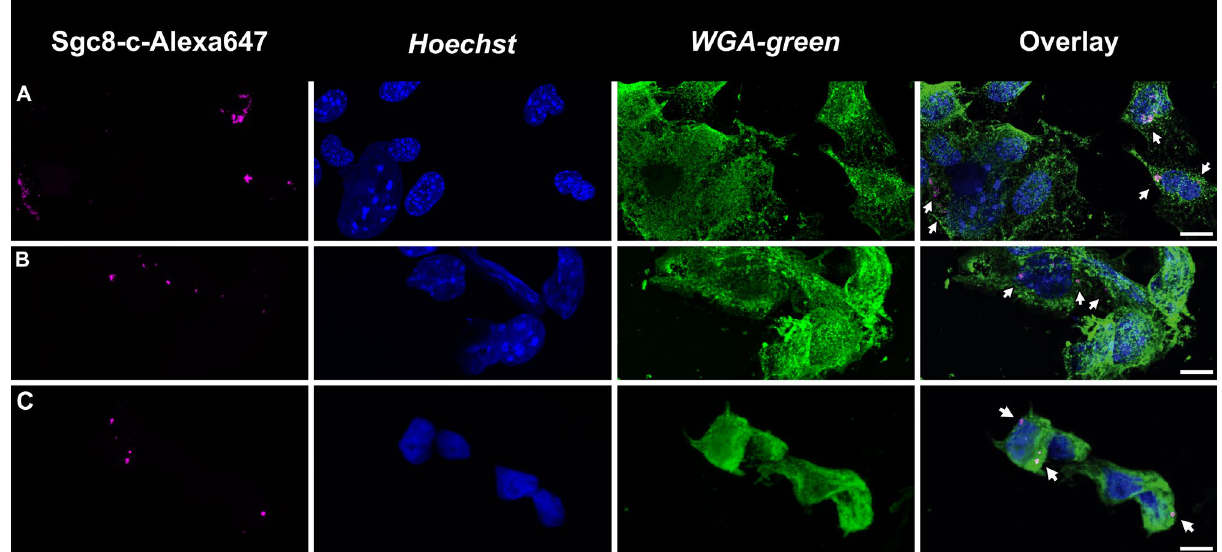
Figure 4. Confocal microscopy of B16F10 tumor cells incubated with fluorescent probe Sgc8-c-Alexa647. Cells were incubated with the probe for ( A ) 2 h, ( B ) 4 h, and ( C ) 16 h. Magenta: Sgc8-c-Alexa647 (white arrows), Blue: Hoechst and Green: WGA-green . Scale bar: 10